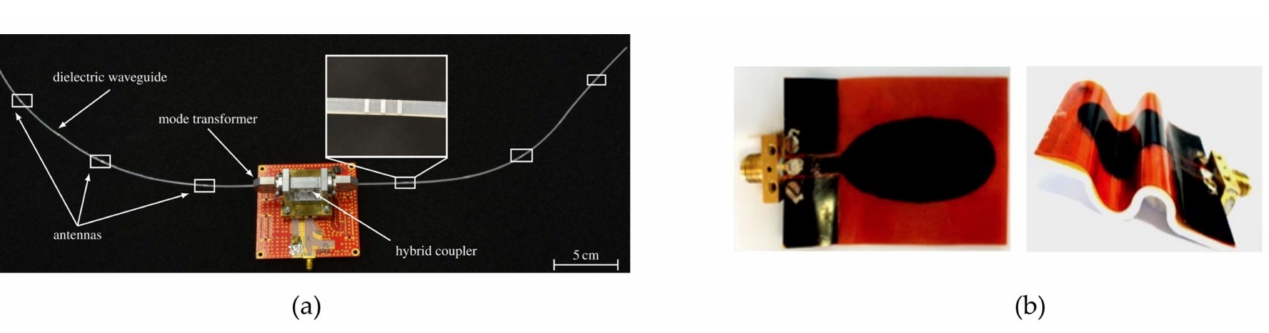
Figure 4. ( a ) HDPE as a dielectric waveguide for distributed radar antennas, reprinted with permis- sion from [108]. Copyright IEEE 2019. ( b ) PANI/MWCNT fabricated antenna on a Kapton substrate, demonstrating good flexibility; reprinted with permission from [109]. Copyright John Wiley and Sons